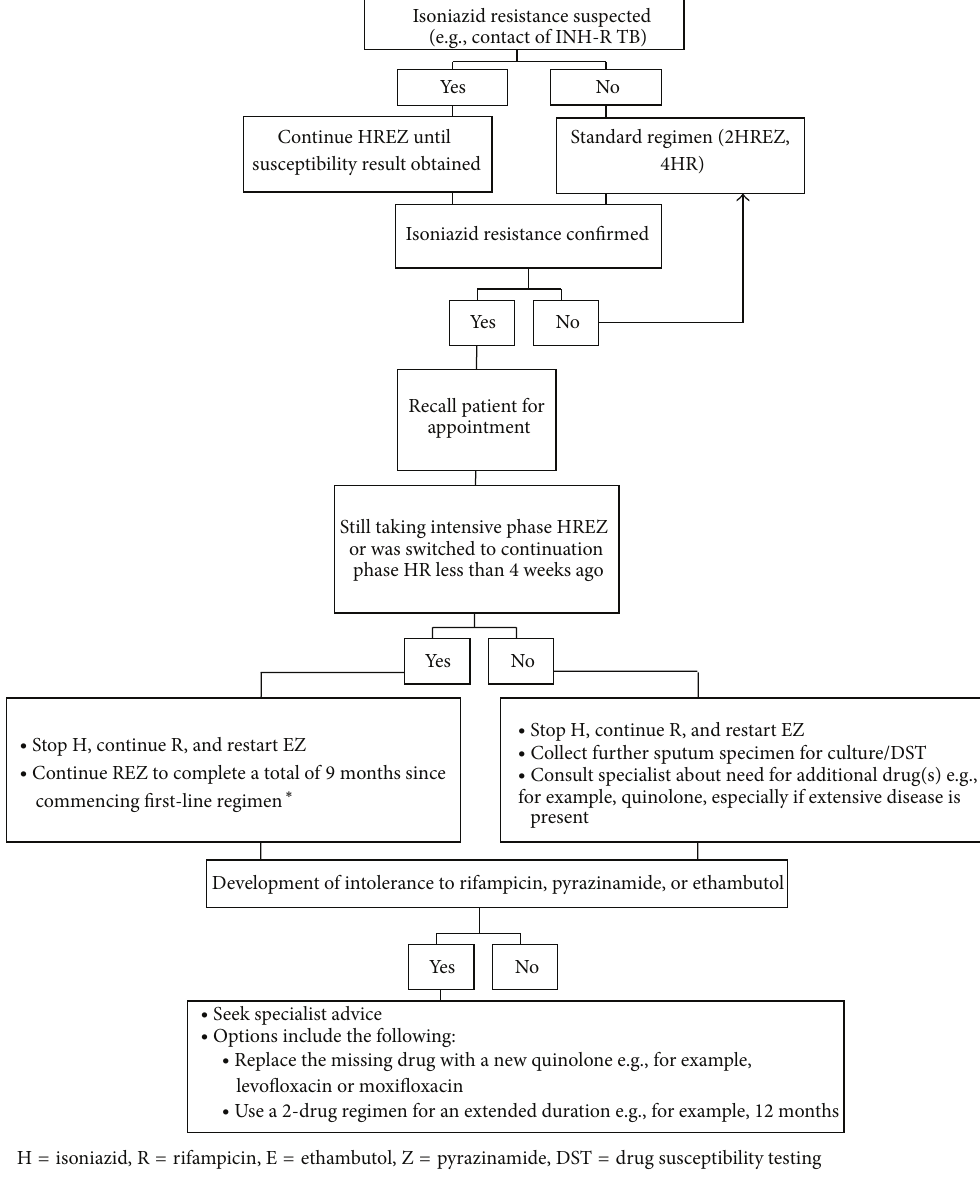
Figure 3: Algorithm for managing isoniazid